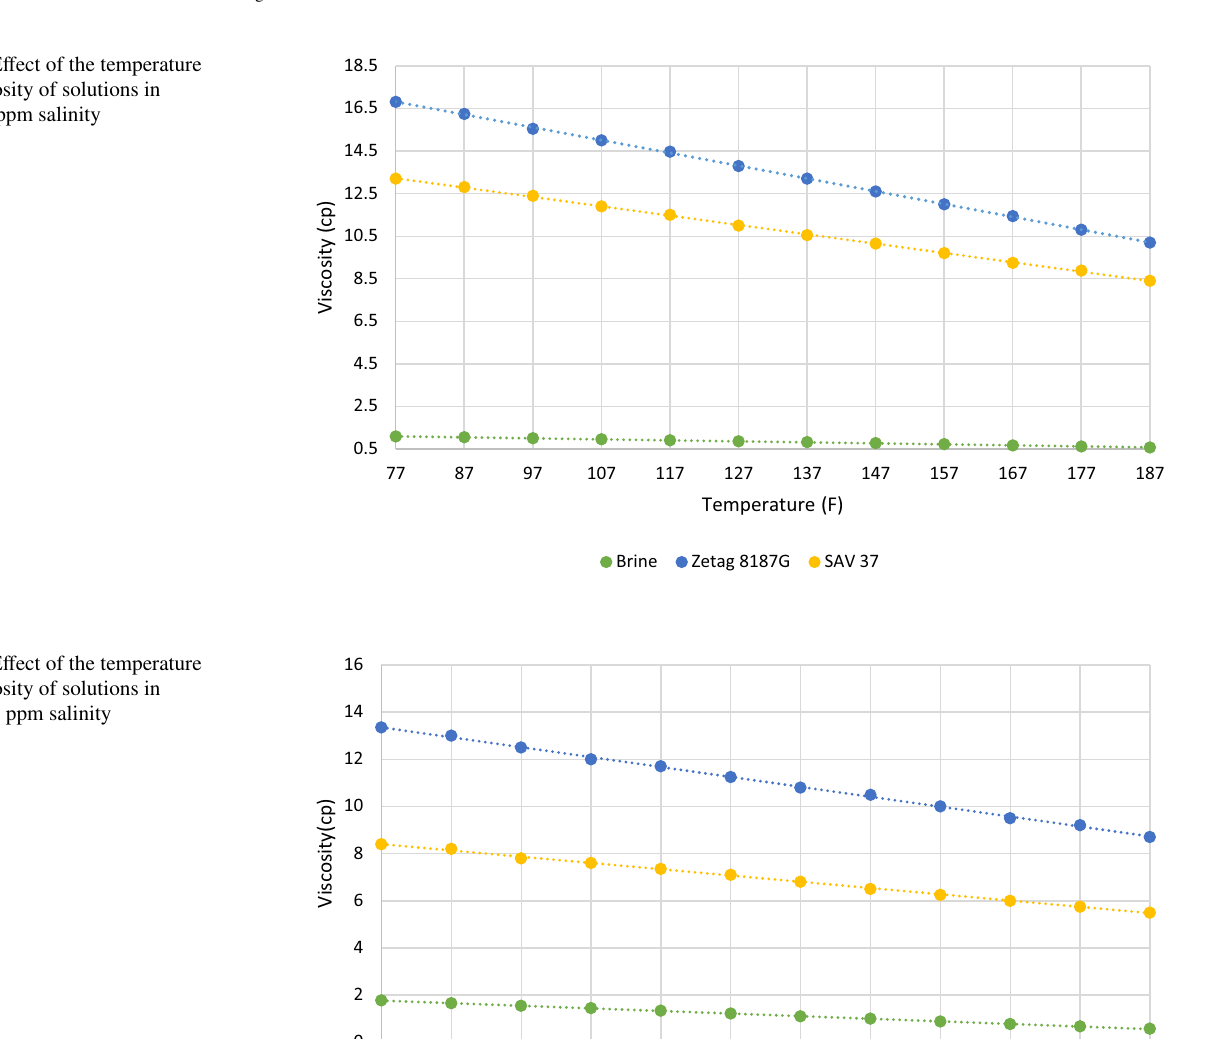
Fig. 5 Effect of the temperature on viscosity of solutions in 10,000 ppm salinity